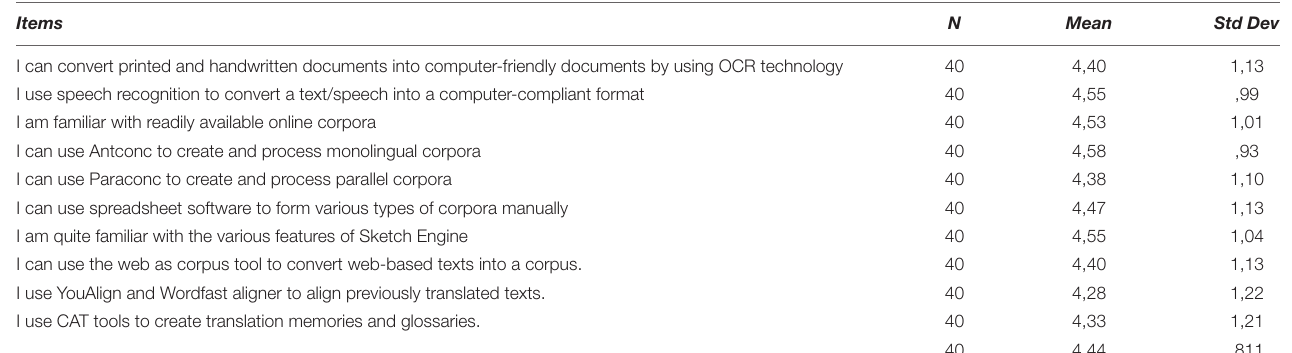
TABLE 4 | Descriptive statistics for trainees’ perceptions toward their instrumental